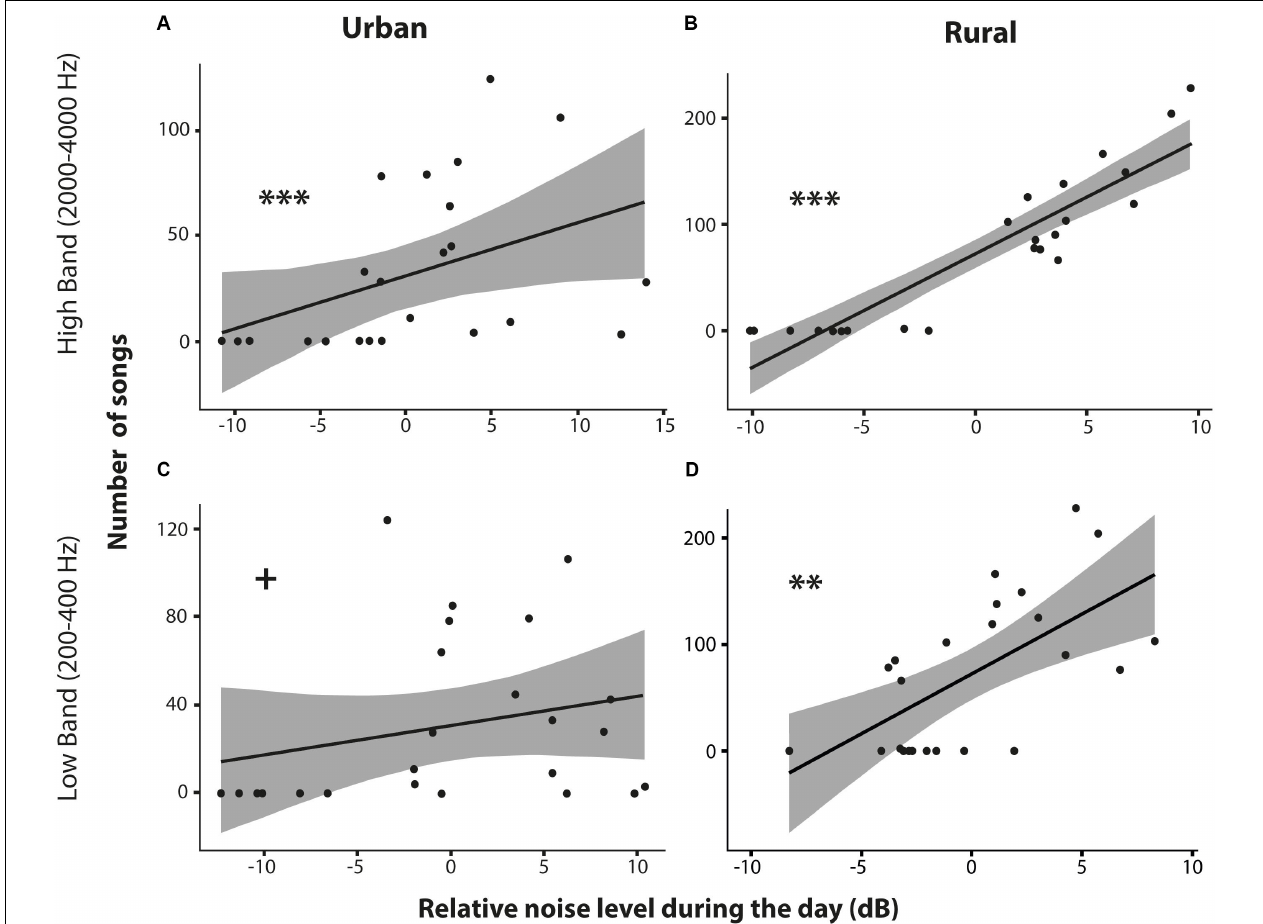
FIGURE 6 | Relationship between the number of songs sung and the relative noise level during the day for the urban and rural pair sites of Amsterdam. Scatterplots for the high band noise (2000–4000 Hz; reflecting bird noise) in the urban (A) and rural (B) sites, and for the low band noise (200–400 Hz; reflecting traffic noise) in urban (C) and rural (D) sites (** and *** indicate significant difference at p < 0.01 and p < 0.001 level and + means a non-significant trend). See text for